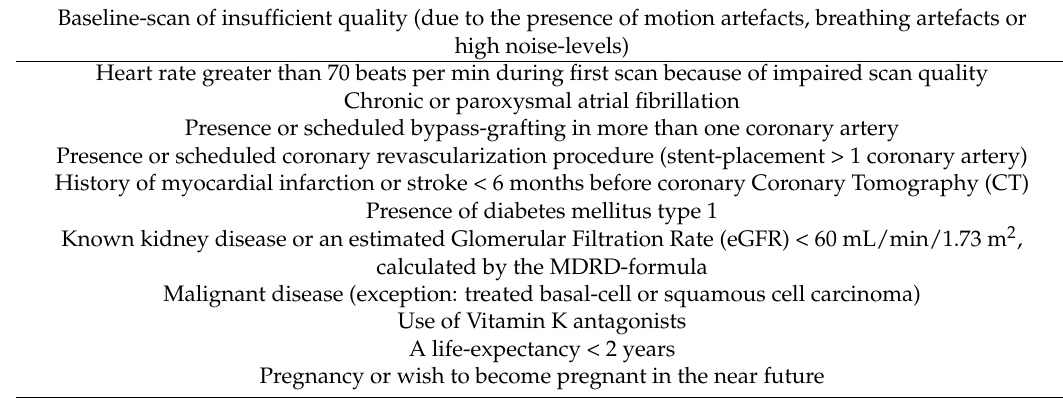
Table 2. Exclusion